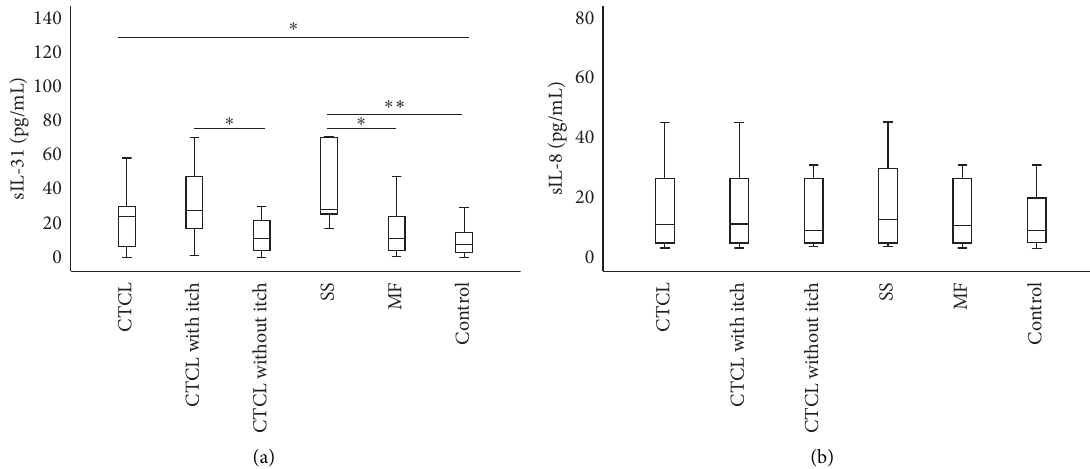
Figure 1: IL-31 (a) and IL-8 (b) serum levels according to diagnosis and to the presence of itch. In this figure, 2 outliers were excluded for sIL-31 (sIL- 31 > 200pg/mL) and 1 outlier was excluded for IL-8 (sIL-8 > 200pg/mL). Statistical analysis was performed using the Mann–Whitney U test. ∗ p < 0 . 05; ∗∗ p < 0 . 01; and ∗∗∗ p < 0 . 001. Statistics for sIL-31 (including/excluding the outliers): CTCL vs . controls: p � 0 . 012/ p � 0 . 032; MF vs . controls: p � 0 . 333/ p � 0 . 333; SS vs. controls: p < 0 . 001/ p � 0 . 001; MF vs . SS: p � 0 . 004/ p � 0 . 024; CTCL without itch vs . controls: p � 0 . 430/ p � 0 . 649; CTCL with itch vs . controls: p � 0 . 002/ p � 0 . 007; and CTCL with itch vs . CTCL without itch: p � 0 . 021/ p � 0 . 048. Statistics for sIL-8 (including/excluding 1 CTCL outlier, corresponding to a patient with hyperleukocytosis and sIL-8 > 200pg/mL): CTCL vs . controls: p � 0 . 863/ p � 0 . 946; MF vs . controls: p � 1 . 000/ p � 1 . 000; SS vs . controls: p � 0 . 740/ p � 0 . 893; MF vs . SS: p � 0 . 639/ p � 0 . 958; CTCL without itch vs . controls: p � 0 . 783/ p � 0 . 914; CTCL with itch vs . controls: p � 0 . 726/ p � 0 . 973; and CTCL with itch vs . CTCL without itch: p � 0 . 743/ p � 0 . 916.CTCL,cutaneousT-celllymphoma;MF,MycosisFungoides;SS,S´ezarysyndrome;sIL-8,interleukin-8serumlevels;andsIL-31, interleukin-31 serum